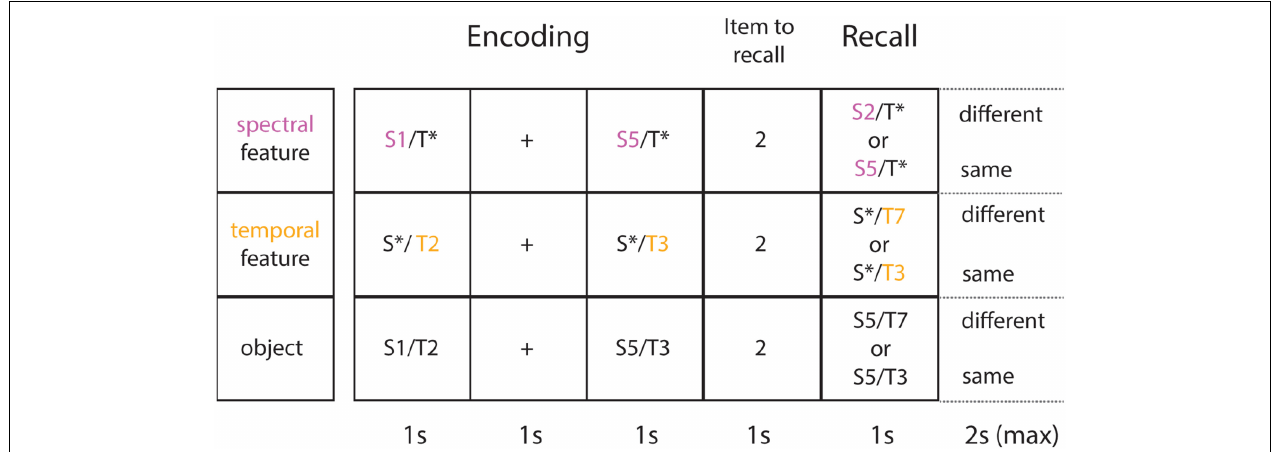
FIGURE 2 | Task and control conditions. Shown are sample trials for each control condition (each row illustrates one of 3 conditions). In the spectral control condition (1st row) subjects focus only on the spectral feature (in purple). In the temporal control condition (2nd row) subjects only focus on the temporal feature (in yellow). In the object control condition (3rd row), they encode the object as a whole (both features in combination). Both single feature control conditions differ